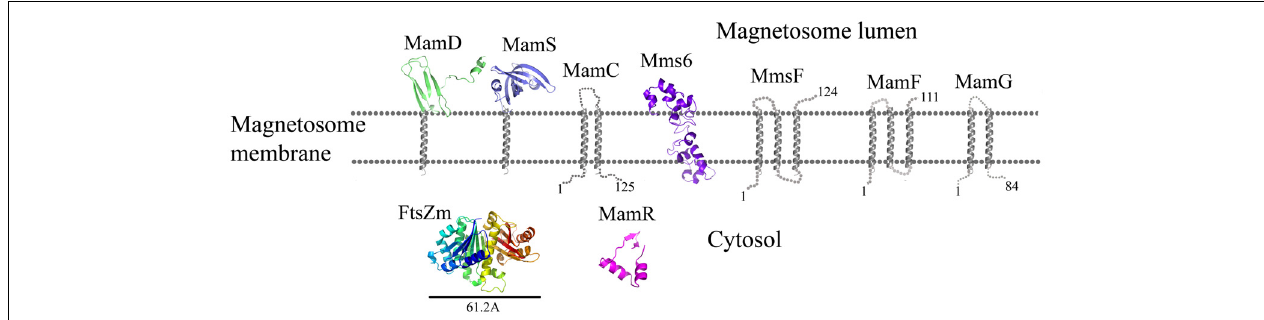
FIGURE 6 | Protein structure predictions that are involved in controlling the size and shape of the magnetite particles. Structures are in ribbon representation. Predictions of anchoring transmembrane helices are in gray. Black bars define the protein size in angstroms.